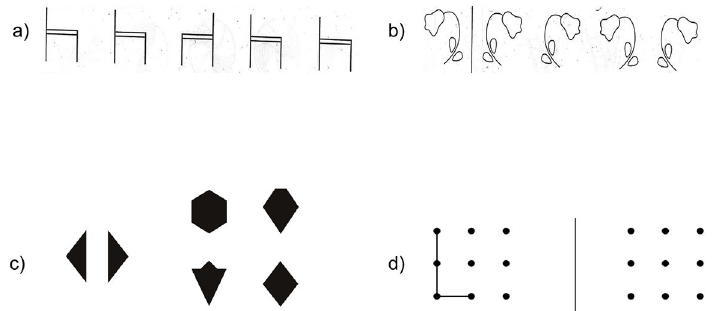
Figure 1. Sample Items of the a) First and the b) Second Part of the Spatial Orientation Task, c) the Spatial Visualization Task and the d) Task of Visuo-Motor Integration. (Figure 1a and 1b reprinted from “Test de développement de la perception visuelle”, by M. Frostig, 1973. Copyright 1973 by Les Editions du Centre de Psychologie Appliquée). Quantitative